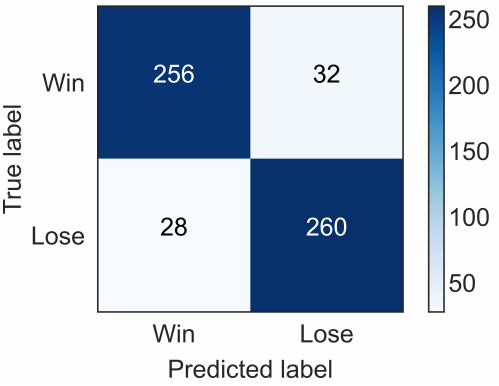
Figure 2. Confusion matrix showing the true and predicted results.